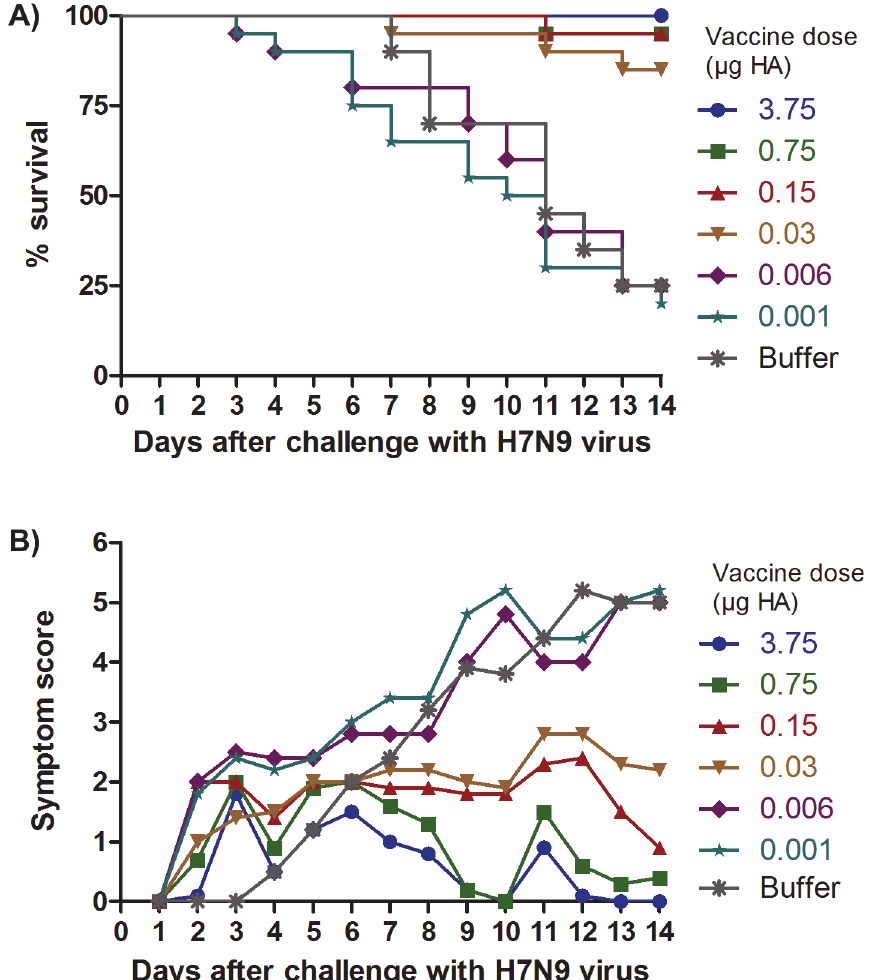
Fig 2. Dose-dependent protection against disease symptoms and death in H7N9-challenged DBA/2J mice immunized with whole-virus H7N9 vaccine. (A) Kaplan-Meier survival curves, (B) Severity and duration of disease